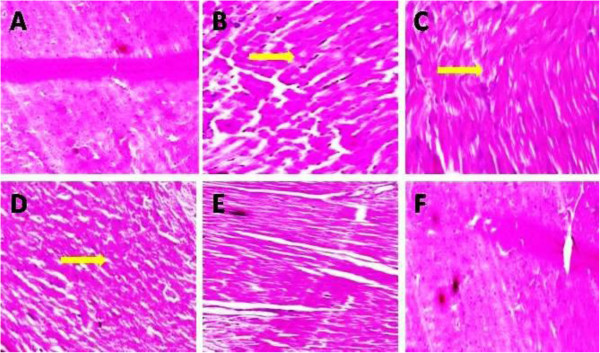
Paederia Foetida Linn. leaves extract effect on heart histopathology in normal and STZ induced diabetic rats. (A) Normal control: Normal histopathology (B) Diabetic control: Display increased interstitial space and distort the intercalated disc (yellow arrow). (C)PF I (100 mg/kg): Display less interstitial space and intercalated disc (yellow arrow). (D)PF II (250 mg/kg): PF treated drug display only space in intercalated disc (yellow arrow). (E)PF III (500 mg/kg): Did not display any changes of the heart histopathology (F) Glibenclamide (10 mg/kg): Histopathology similar to the normal group. The samples were obtained from the same liver anatomical regions. For each group, 6 rats were examined and 50 pictures were taken. Original magnification, 10×.